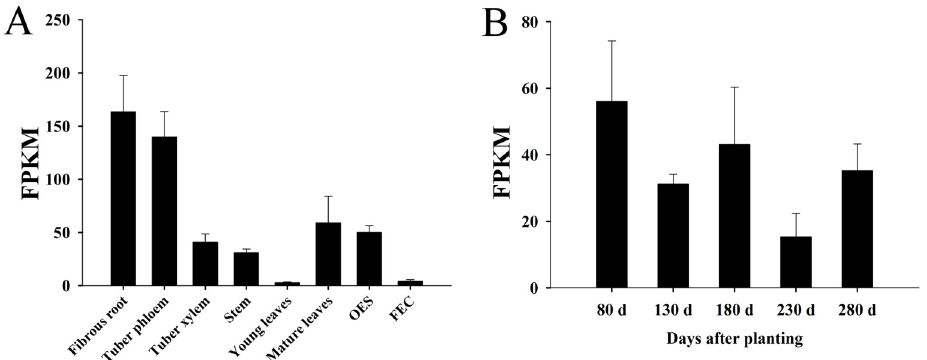
Figure 4. Expression analysis of the MeNINV1 gene in cassava tissues and organs and during tuber root development. ( A ) Tissue and organ expression analysis of the MeNINV1 gene. ( B ) Expression analysis of the MeNINV1 gene during tuber root development. Data are the mean ± SD of three independent assays. FPKM—Fragments per kilobase per exon model per million mapped fragments.